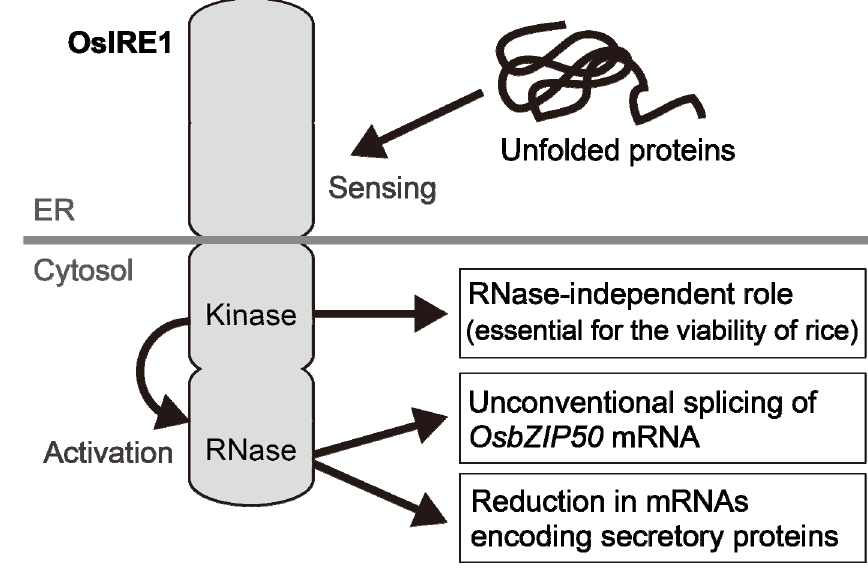
Figure 2. Multiple roles of IRE1 in rice. The kinase activity of IRE1 is assumed to contribute to activation of the RNase domain. RNase activity is involved in the unconventional mRNA splicing of OsbZIP50 and the reduction of mRNAs encoding secretory proteins, such as PR proteins. Kinase activity plays some role independent of RNase activity that is essential for the viability of